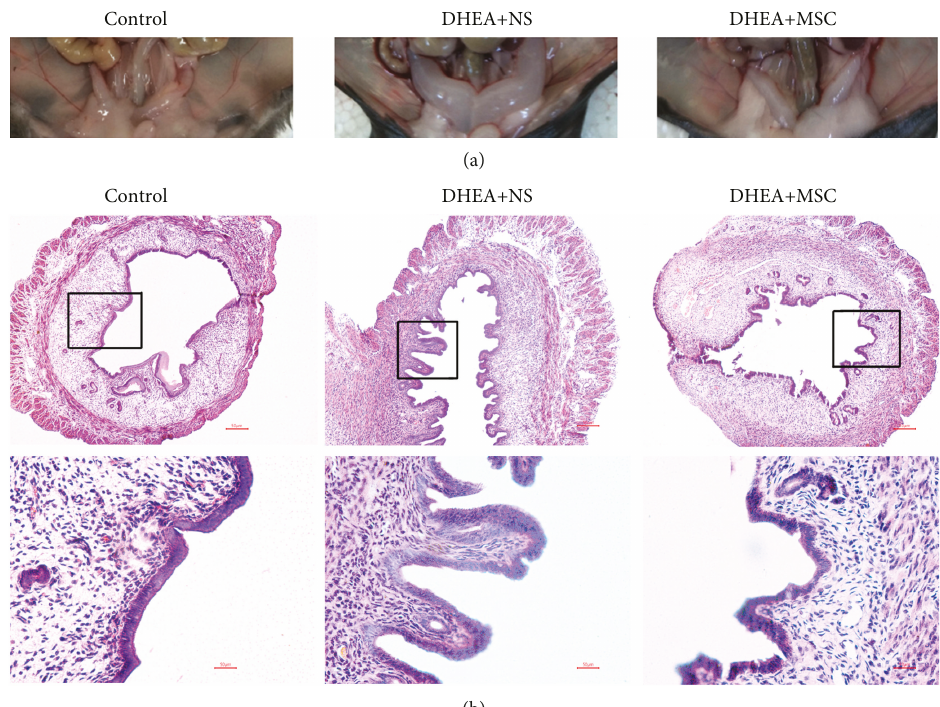
Figure 2: hUC-MSC treatment improves uterine pathological changes in PCOS mice. (a) Morphology of uterine tissue. (b) Representative hematoxylin and eosin (H&E) staining of uterus sections. Scale bars: 50 μ